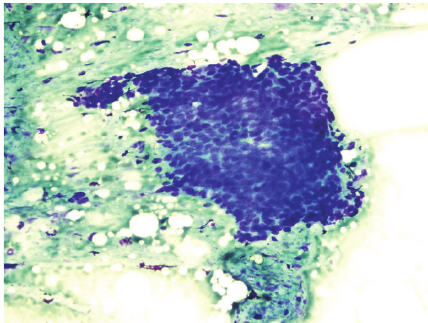
Figure 1: Microscopic findings of fine needle biopsy.